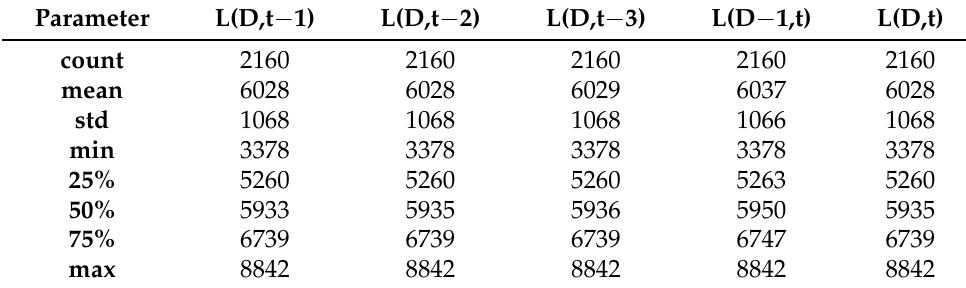
Table 3. MLR: Statistical information of active power load dataset.